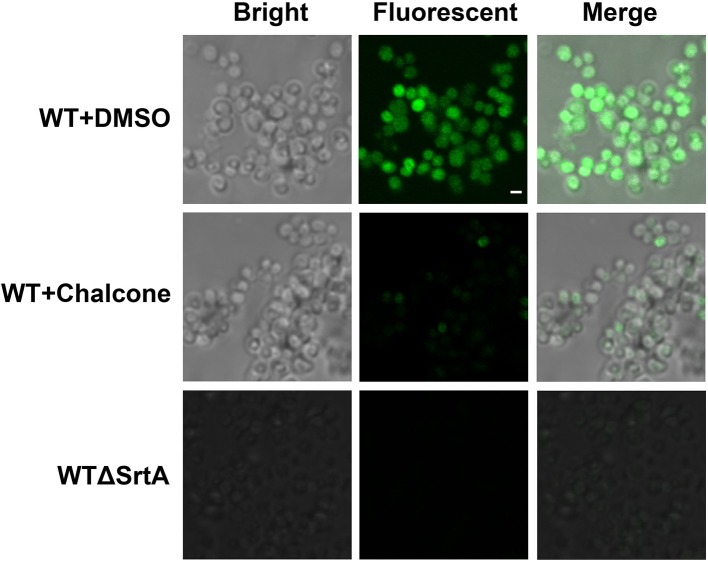
Effects of chalcone on SpA display in S. aureus. A confocal laser-scanning microscope was used to view the binding of FITC-labeled Ig to SpA. The strength of the green color represents the amount of the SpA anchored to the surface of bacteria. Scale bar, 1 μm.